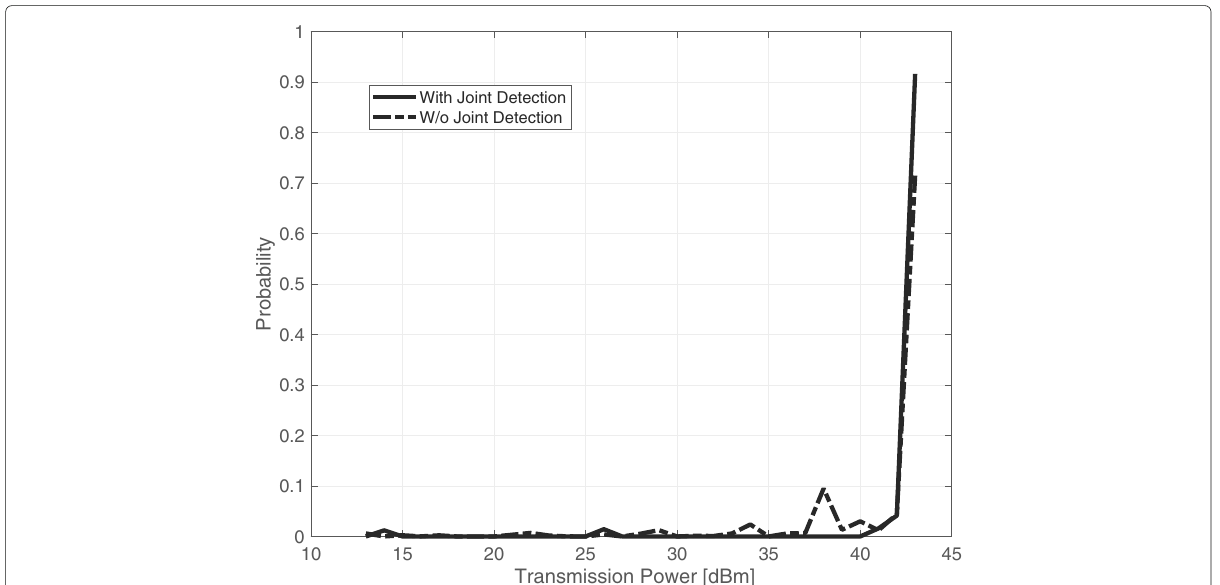
Fig. 12 Probability distribution of MBS transmission power (10 users/sector, PBS: 2(cell